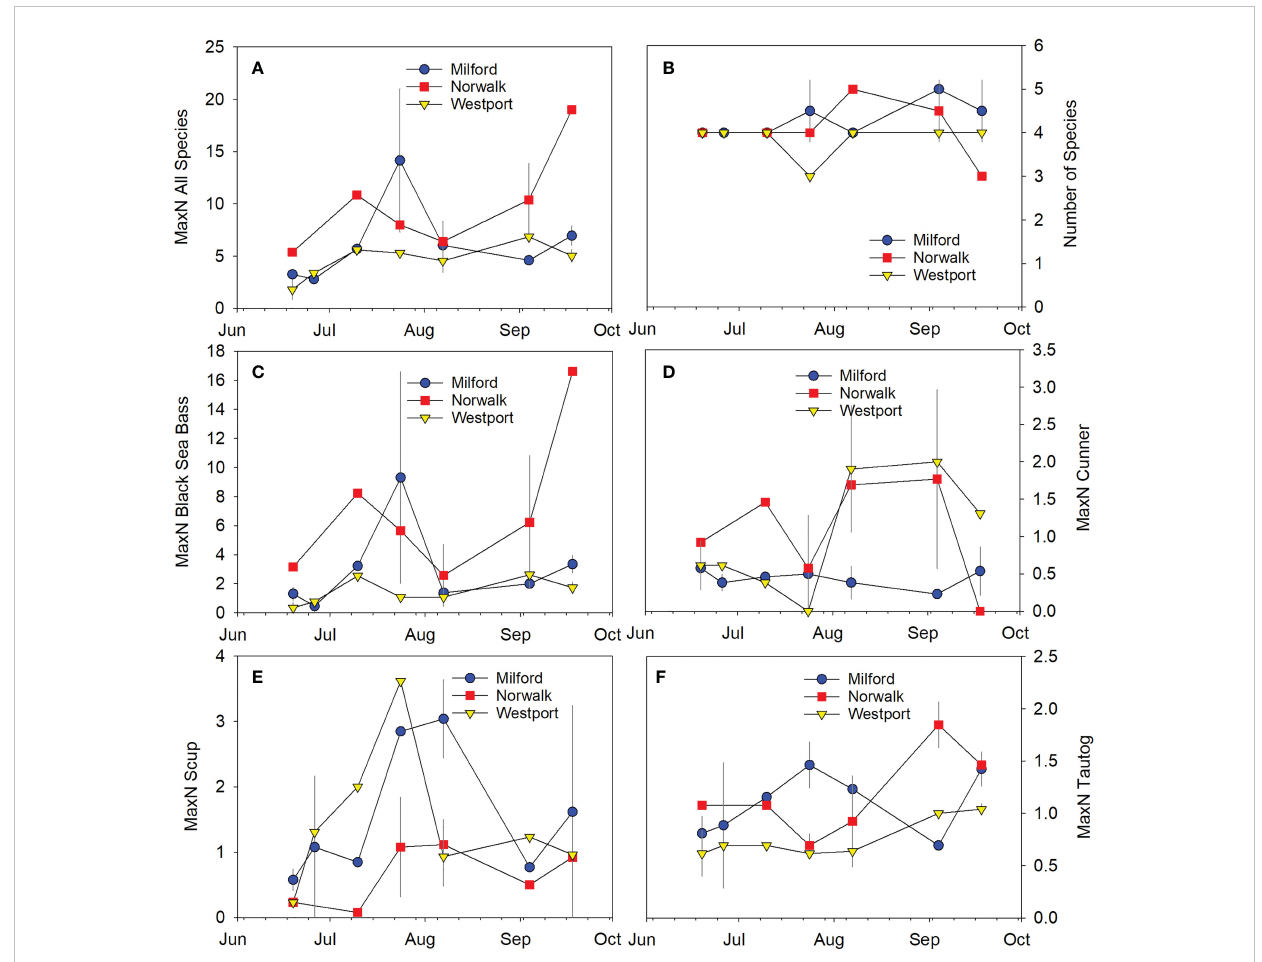
FIGURE 6 Time series of fi sh abundance and species richness at the three commercial shell fi sh farms sampled in 2019. Symbols indicate mean ± SD. (A) Total fi sh abundance across all species, (B) Species richness, (C) Black sea bass, (D) Cunner, (E) Scup, (F)